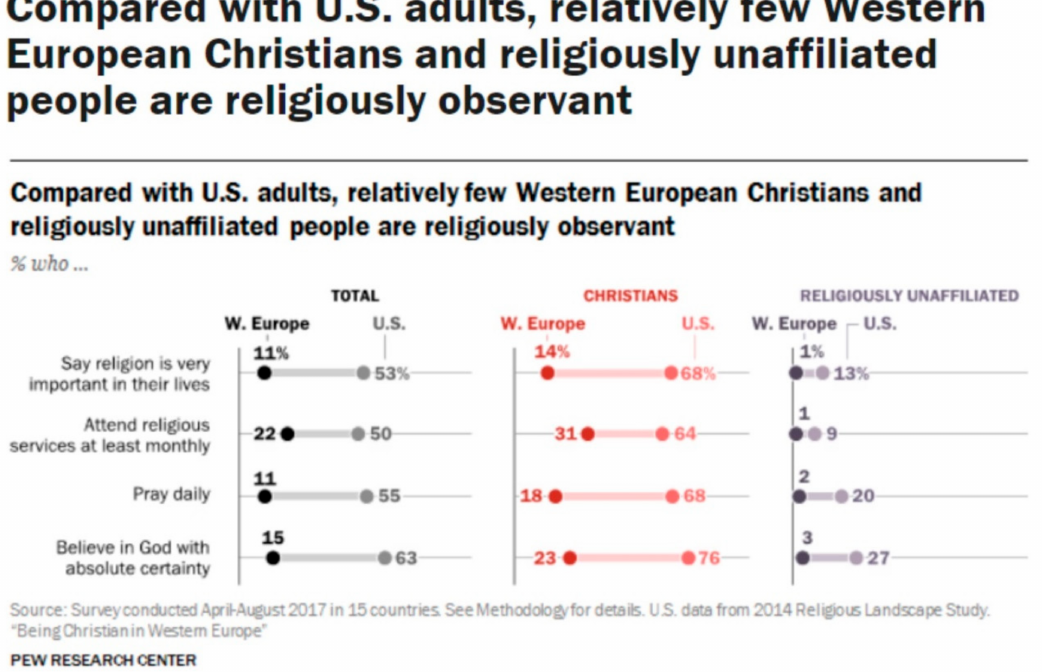
Figure 1. Religious observance among Christians and the Una ffi liated in Western Europe and the U.S. (Sahgal